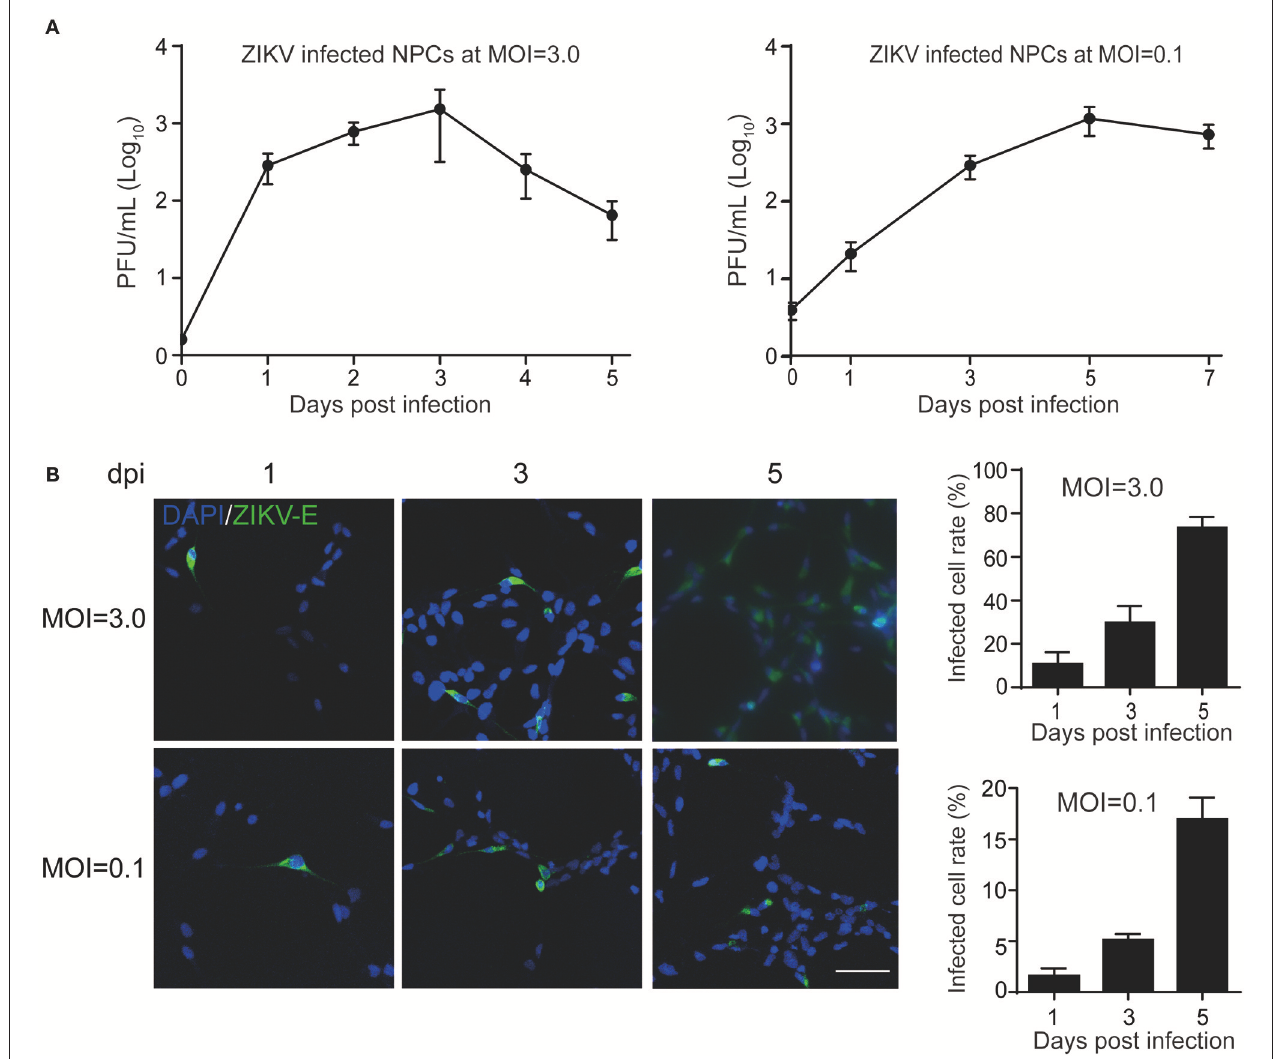
FIGURE 1 | Human neural progenitor cells (NPCs) are permissive to ZIKV infection. NPCs were infected with ZIKV at an MOI of 3.0 and 0.1, respectively, for the detection of virus titers in the supernatant and the infected cell rates. (A) ZIKV growth curves. NPCs were infected with ZIKV at an MOI of 3.0 and 0.1, respectively. Supernatant samples were collected at the indicated time points. Virus titers in supernatant samples were determined by plaque forming assay in triplicate. (B) ZIKV E protein positive cell rates. NPCs on coverslips were infected with ZIKV at an MOI of 3.0 and 0.1, respectively. Coverslips were collected at the indicated time points. The expression of ZIKV E was stained with anti-ZIKV E protein antibody by IFA. The ZIKV-infected cell rates were determined by counting the ZIKV E protein positive cells vs. total cells stained with DAPI per 500 µ m 2 in 3 different images. Scale bar, 200 µ m.